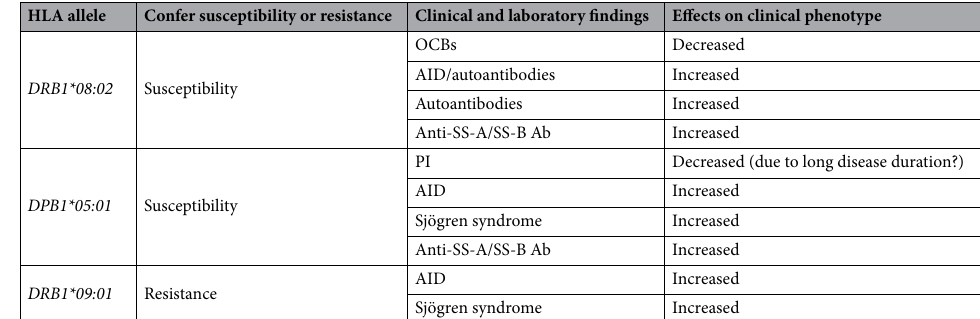
Table 5. Summary of HLA genotype-clinical phenotype correlations in NMOSD. If the effects were derived from only 5 or less than 5 positive cases, such findings were regarded as too preliminary, and therefore they are not described in the table. Ab antibody, AID autoimmune disease, ANA anti-nuclear antibody, NMOSD neuromyelitis optica spectrum disorders, OCBs oligoclonal IgG bands, PI Progression